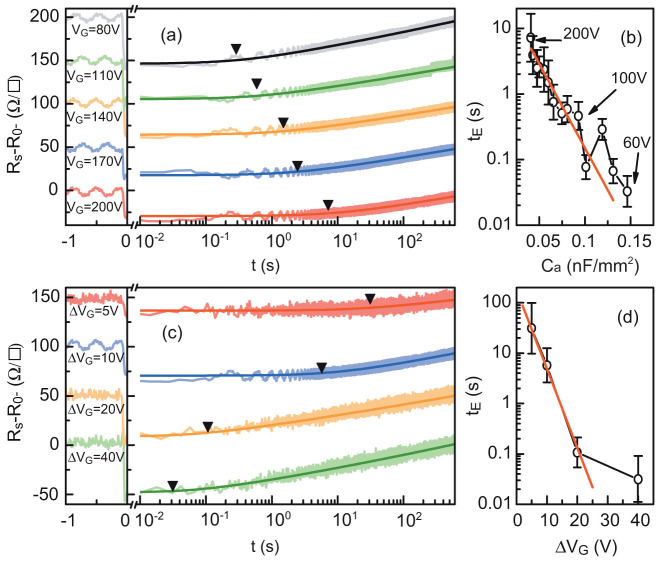
(a) Resistance over time of the LaTiO3/SrTiO3 sample, measured at 4.2 K for different gate voltages after a ΔVG = +10 V step, fitted by equation (6). Arrows indicate tE values extracted from the fits. (b) Logarithm of tE, plotted as a function of Ca and fitted with equation (7) (red line). (c) Resistance over time, measured at 4.2 K for different steps ΔVG, and fitted with equation (6). Arrows indicate tE values extracted from the fits. (d) Logarithm of tE plotted as a function of ΔVG and fitted with equation (7).